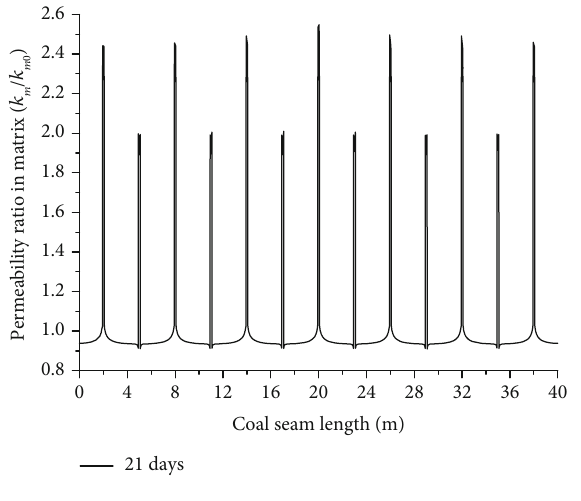
Figure 10: Fluid saturation in coal fracture.